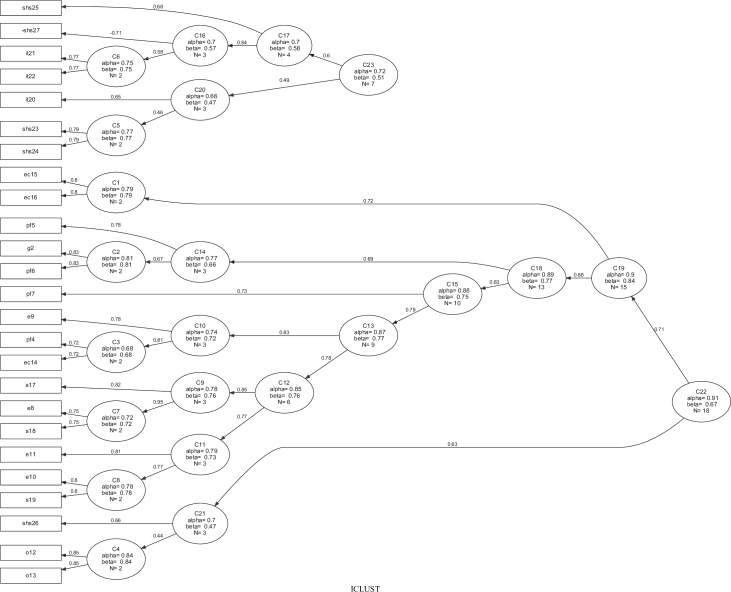
Questionnaire item clustering (n = 100).Clusters were formed using the ICLUST algorithm, after deleting cluster C17 (items G1 and G3), resulting in two higher-order clusters: C23 = Perception about health services and treatment; C22 = General impacts.